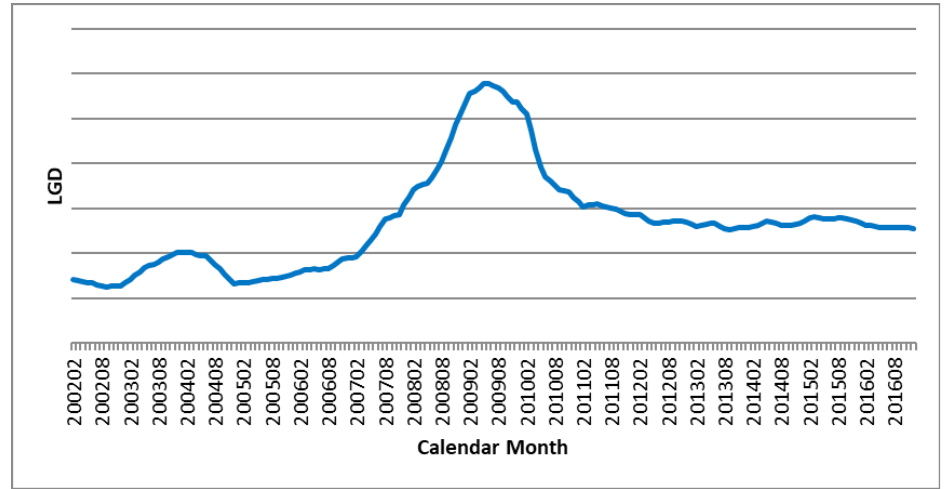
Figure 6. LGD by calendar month used as target in the ECM.